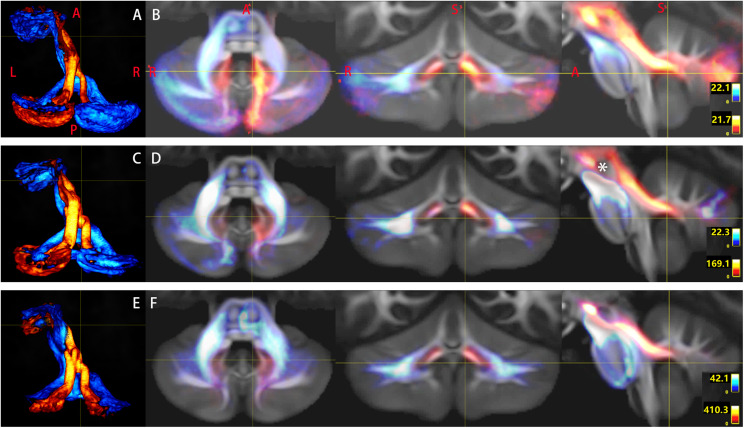
Tridimensional views of the pathways of Crus–Broca tracts (hot colors)/Broca–Crus tracts (cold colors) from all subjects as reconstructed by DSI Studio (A,B), FSL (C,D), and MRtrix3 (E,F). (A,C,E) Pathways of the two kinds of tracts. (B,D,F) (1) Crus–Broca tracts are closer to the uvula and the pyramid than the dentate nucleus (DN) is and are closely above the superior border of the supratonsillar cleft; (2) Crus–Broca tracts bypass the left red nucleus; and (3) distributions of origin points of Crus–Broca tracts and target points of Broca–Crus tracts in the medial and the exterior part of Crus regions of interest, respectively. Each image shows Crus–Broca tracts/Broca–Crus tracts from all subjects by interactively resetting the image scaling to optimally display part of the Crus–Broca tracts that go through the DN and superior cerebellar peduncle. The asterisk in (D) indicates the left red nucleus. The focus point in (B,D,F) indicates the supratonsillar cleft.